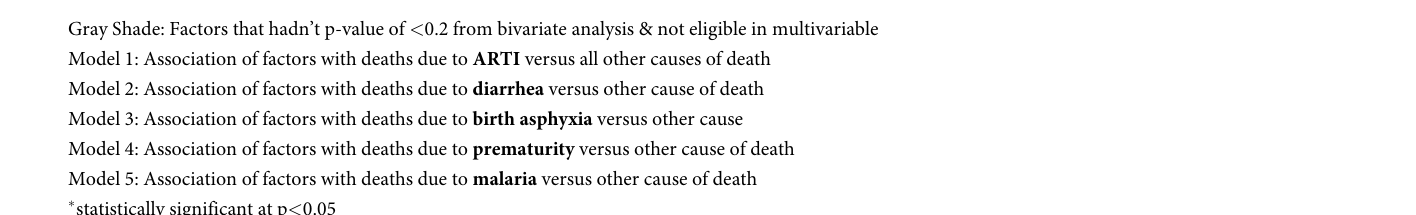
2 times higher chance of infant death due to diarrhea than other cause of death ( P = 0.006, AOR: 2.38, 95% CI: 1.28, 4.44) (see Table 3). Infant mortality from birth asphyxia shows a statistical significant relationship, but less likely to occur, with male sex ( P = 0.039, AOR: 0.52, 95% CI: 0.28, 0.97) and being died out of heath facilities ( P = 0.002, AOR: 0.32, 95% CI: 0.16, 0.66), as compared to mortality from all other causes. Infant died out of health facilities was the only associated factor with prematurity death, but lower odds ( P = 0.001, AOR: 0.24, 95% CI: 0.10, 0.57) (see Table 3). Infant who died from malaria is more closely associated with age of mothers between 20–35 years old and infant who resided in districts of Afar region. Infant with age of mothers between